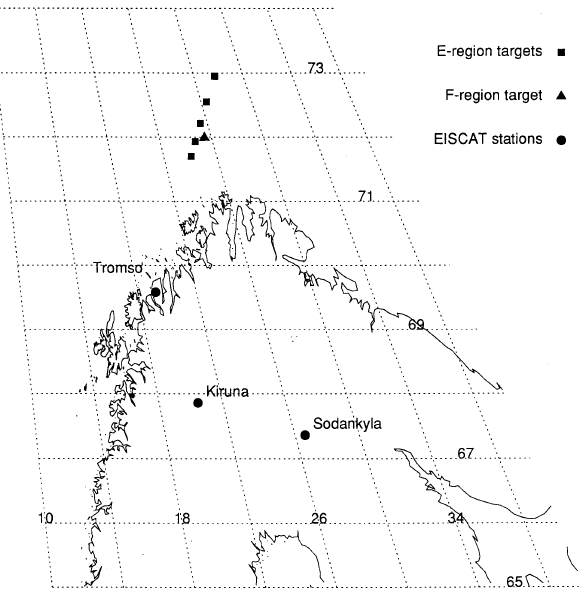
Fig. 1. A map of the EISCAT station locations and target positions for this